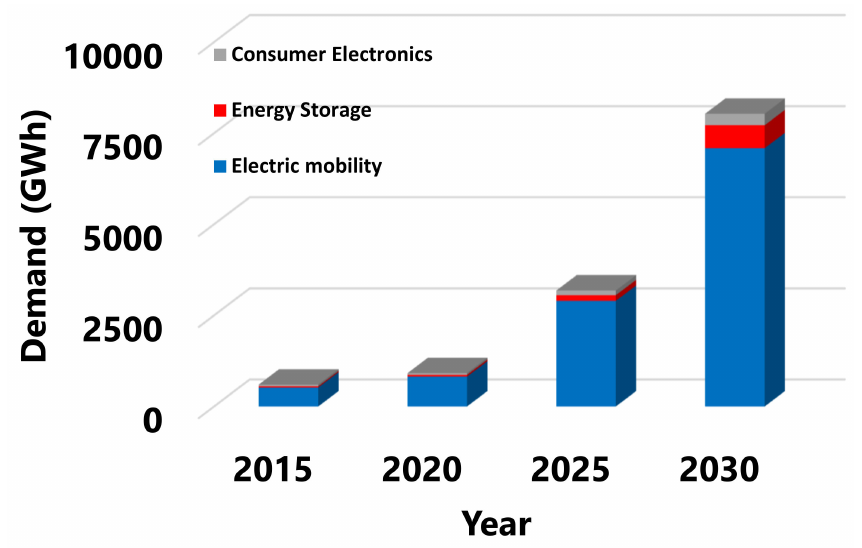
Figure 4. Global demand for battery technologies by application from 2015 to 2030 (Data derived from ref.